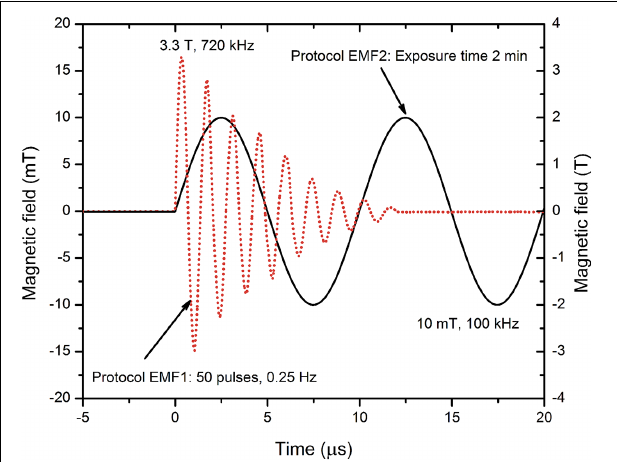
FIGURE 1 | Applied magnetic field protocols. The pulses have been measured using a calibrated loop sensor (VGTU, Vilnius, Lithuania), a DPO4034 oscilloscope (Tektronix, Beaverton, OR, United States), and a Gaussmeter 475DSP (Lakeshore, Carson, CA, United States), post-processed in OriginPro Software (OriginLab, Northampton, MA, United